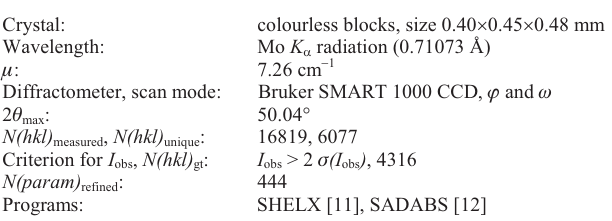
Table 1. Data collection and handling.